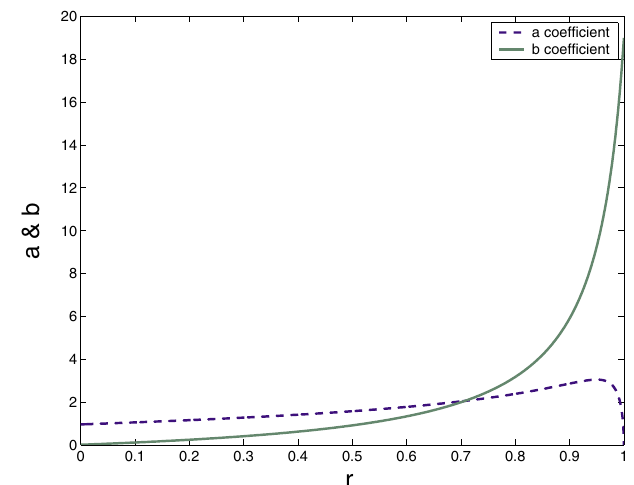
FIG. 2. (Color) Plots of the a and b coefficients for (cid:21) (cid:1) 0 : 05 .